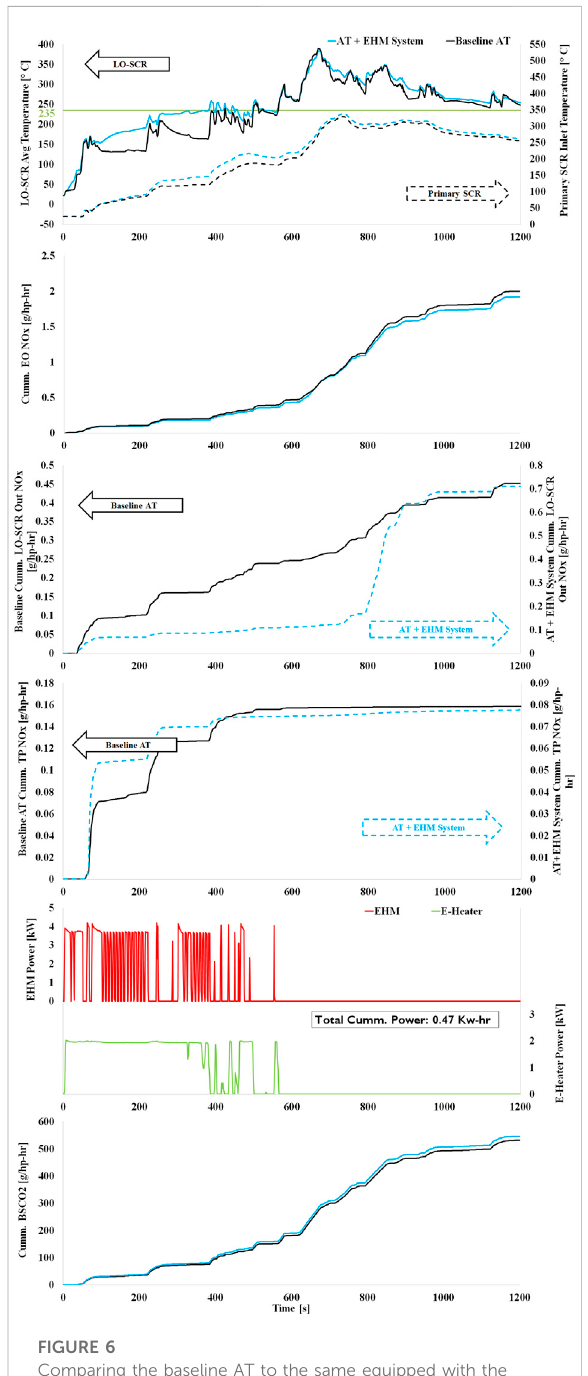
FIGURE 6 Comparing the baseline AT to the same equipped with the EHM system on a cold FTP cycle for the LO-SCR average temperature,primary SCR inlet temperature, EO NO x , LO-SCR out NO x , TP NO x , heater power consumption, and BSCO 2 .